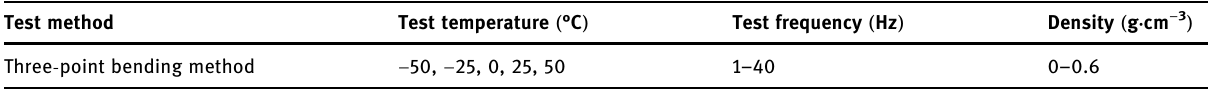
Table 1: DMA test scheme Test method